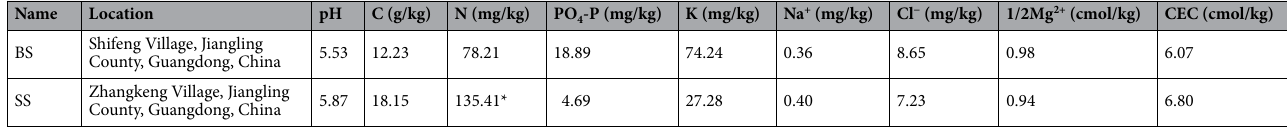
Table 2. Origin and characteristics analysis of field soils used in this study. * p <